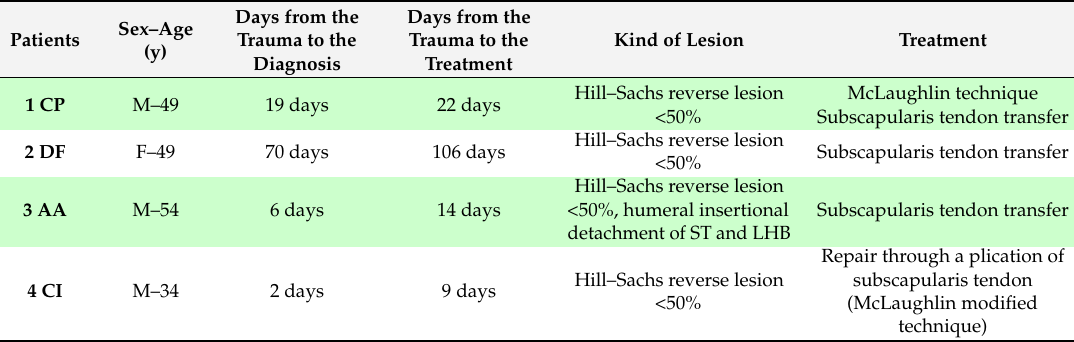
Table 1. Details of treated patients. TS = supraspinatus tendon LHB = long head biceps.